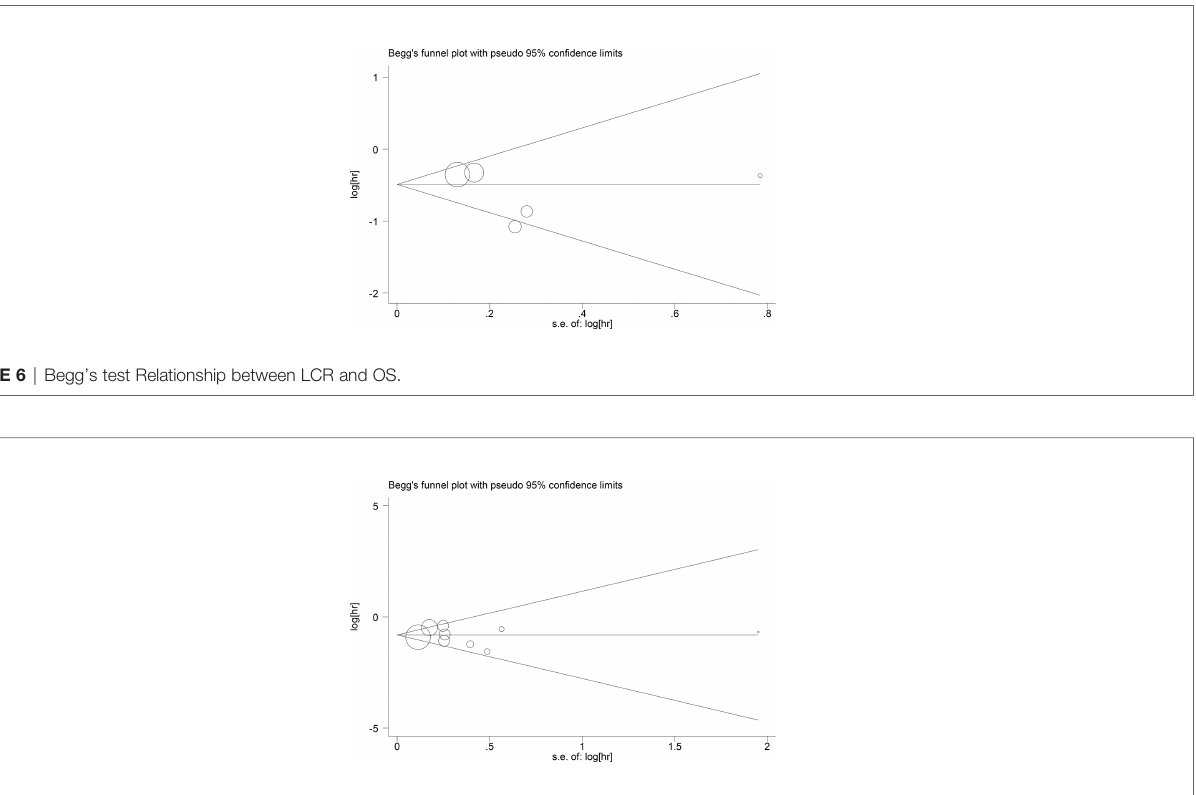
FIGURE 7 | Begg ’ s test Relationship between LCR and DFS.